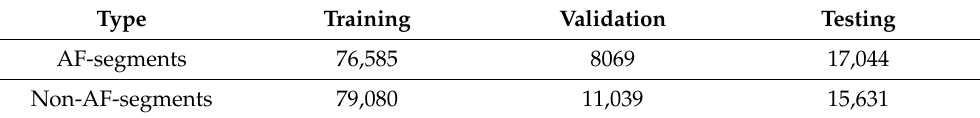
Table 3. Number of segments for AF patients and non-AF candidates